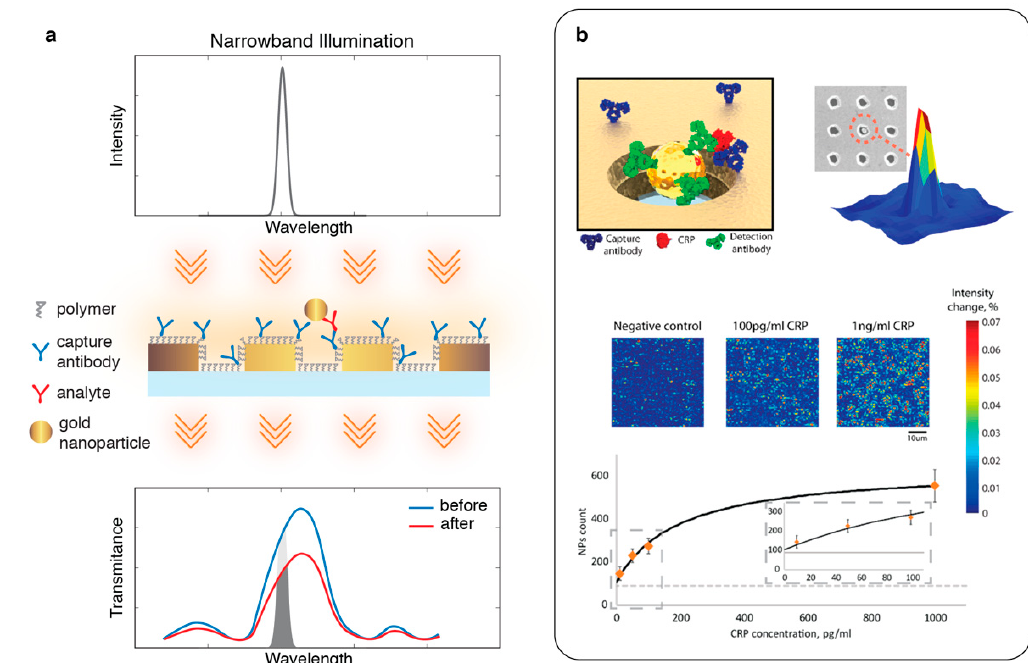
Figure 7. ( a ) Nanoparticle-enhanced plasmonic imaging. Schematic shows a collinear transmission light-path, where a narrowband illumination tuned to the flank of the Au nanohole array resonance peak is used for bright-field imaging. Nanoparticle binding at the nanoholes distort the localized plasmons creating a drastic suppression of the transmission peak, which can be monitored to extract digital analyte binding information; ( b ) (top) schematic shows a sandwich bioassay, antigen being recognized by capture antibodies immobilized on the Au-nanoholes and then by detection antibodies tethered to Au-nanoparticles. Strong local suppression in the transmission create intensity contrast. (bottom) Bright-field images and a calibration curve for human C-reactive Protein detection. Adapted with permission from [90] Copyright 2018 American Chemical Society.